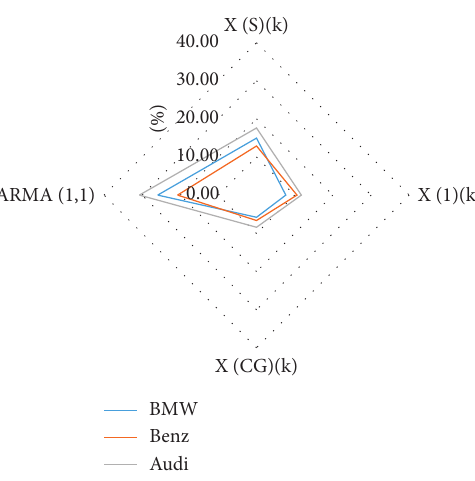
Figure 2: Comparison of error levels of four prediction models. Table 5: Competitive analysis of raw data based on the Lotka–Volterra model.